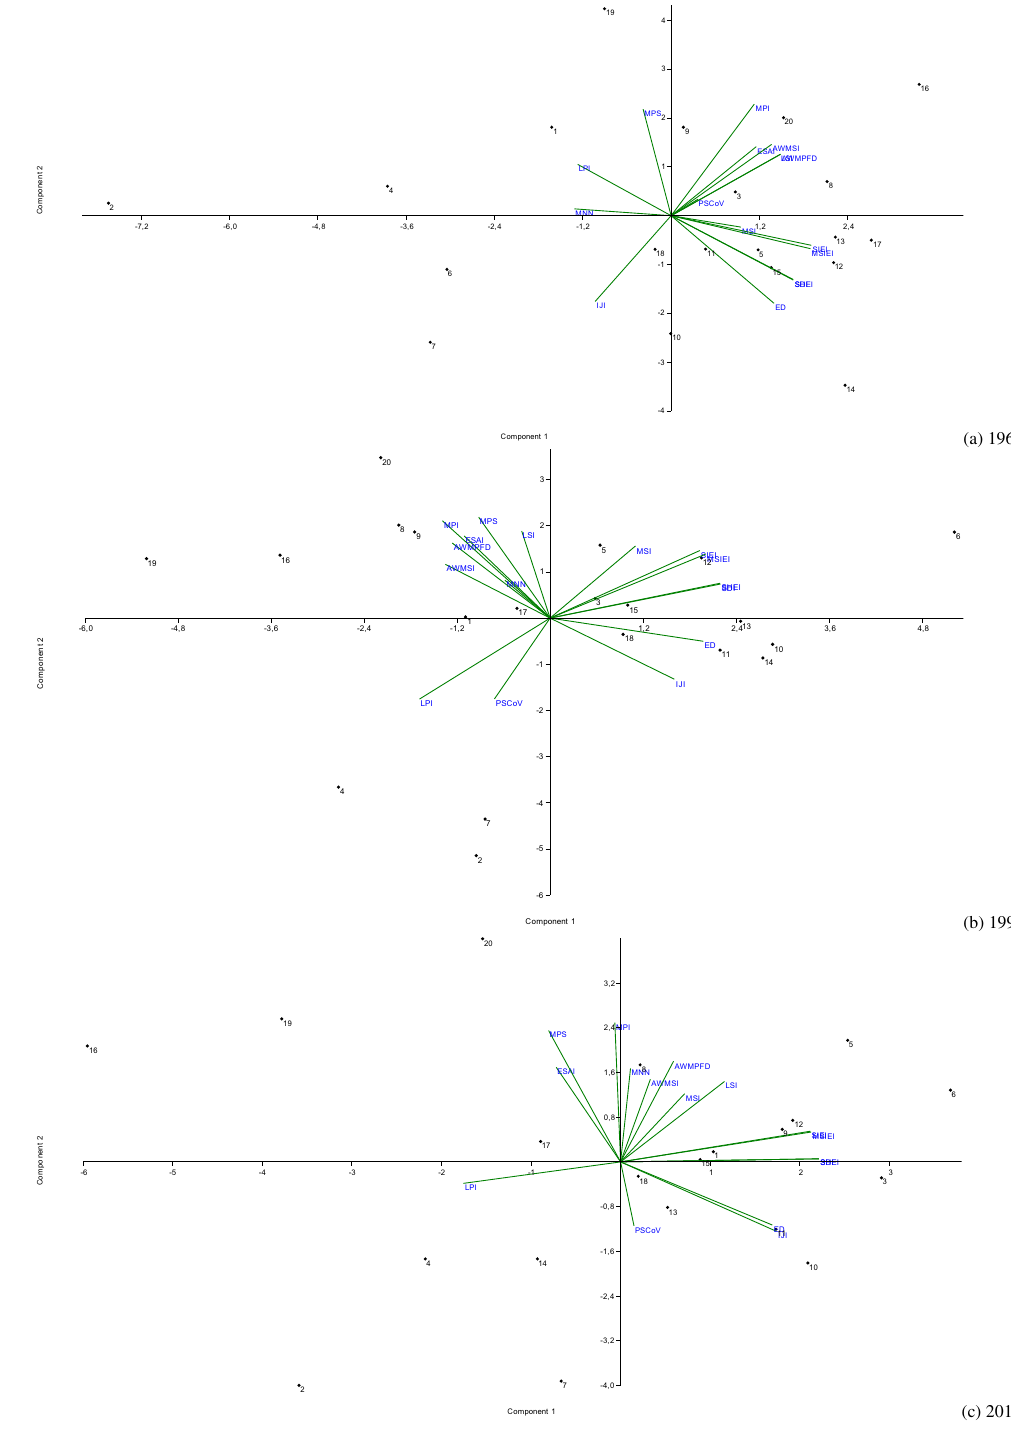
Figure 2. Biplot of a Principal Component Analysis outlining latent relationships between landscape metrics and the level of land vulnerability to degradation (regional codes were reported in Table